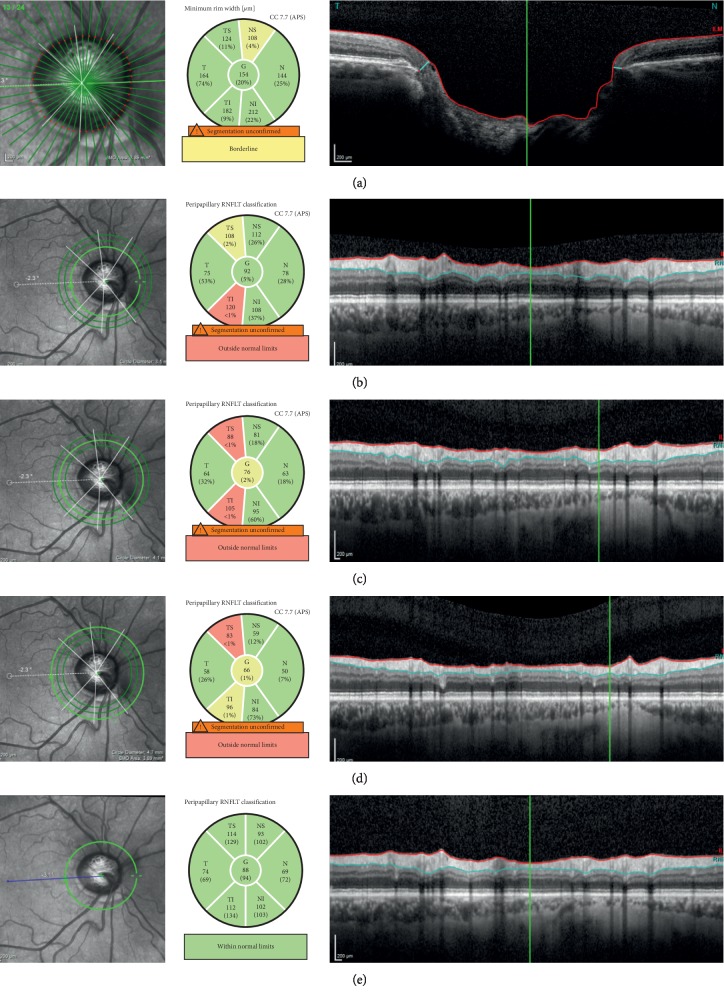
Measurements of the circumpapillary RNFL thickness (between red and blue line) using the new method (RNFLBMO) (a–d) and the conventional method (RNFLDİ), FoBMO(°) angles (dashed white line) (e). (a) Determination of the center of BMO (red dots), infrared image indicating 24 locations where the radial B-scan images (dark green radial lines) were obtained and BMO-MRW thickness (blue arrow) measurements by centering on BMO. (b) RNFLBMO1, peripapillery circle with a diameter of 3.5 mm. (c) RNFLBMO2 peripapillary circle with a diameter of 4.1 mm. (d) RNFLBMO3 peripapillery circle with a diameter of 4.7 mm. (e) Conventional RNFLDİ measurement using the scan circle manually located by the examiner and FoDisc(°) angle (blue line).